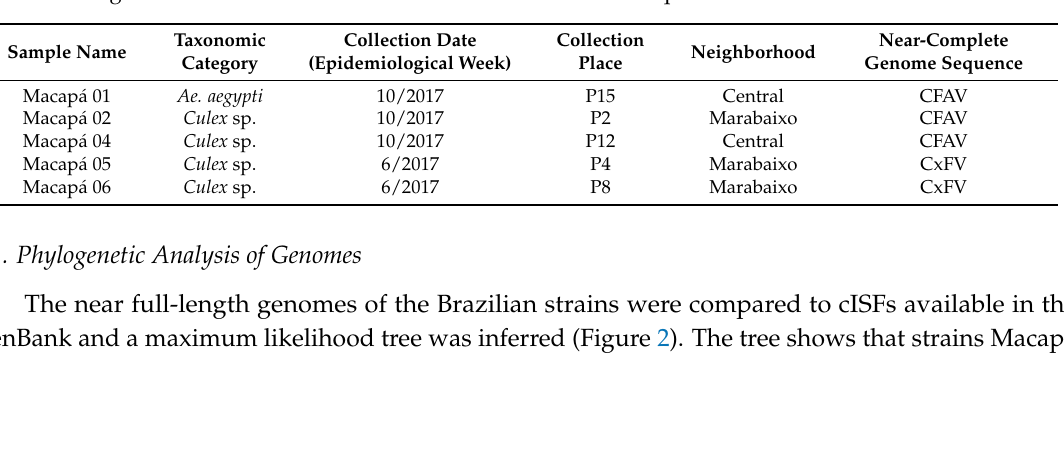
Table 1. Pools of mosquitoes in which near full-length genome sequences of flavivirus were obtained according to their characteristics and information about these